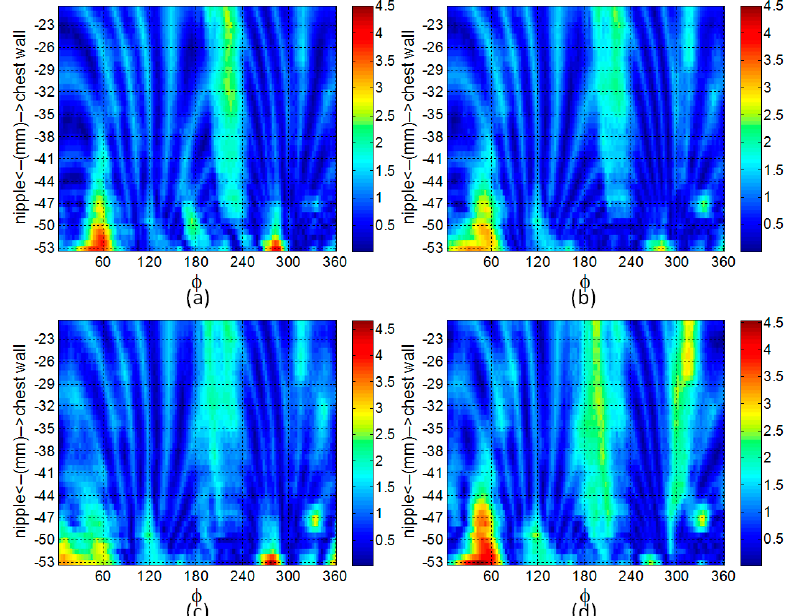
Figure 9. Map showing distance errors (in mm) between the estimated and reference surfaces for model A. The surface is estimated with ( a ) 120, ( b ) 60, ( c ) 20, and ( d ) 15 profiles. Sensors 2017 , 17 , 1658